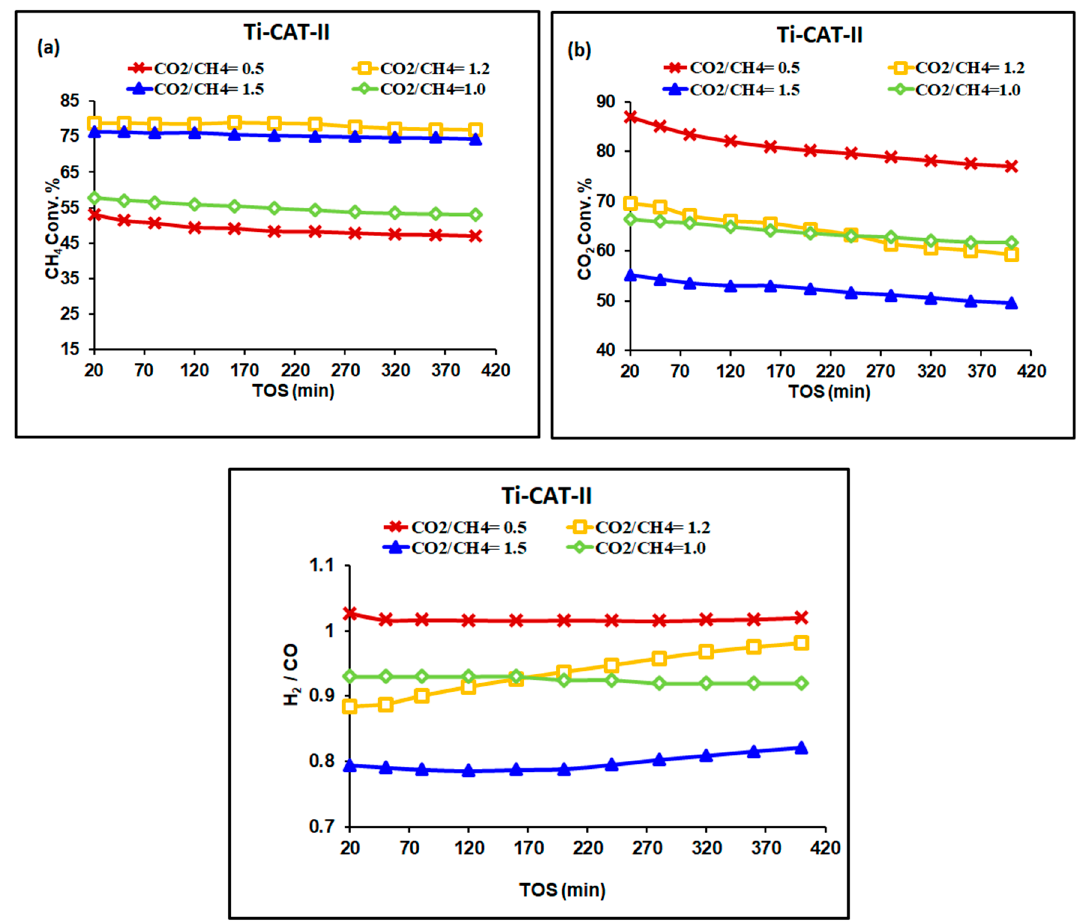
Figure 10. ( a ) CH 4 ( b ) CO 2 conversions, and ( c ) H 2 /CO ratio for different CO 2 /CH 4 ratio over Ti-CAT- II.